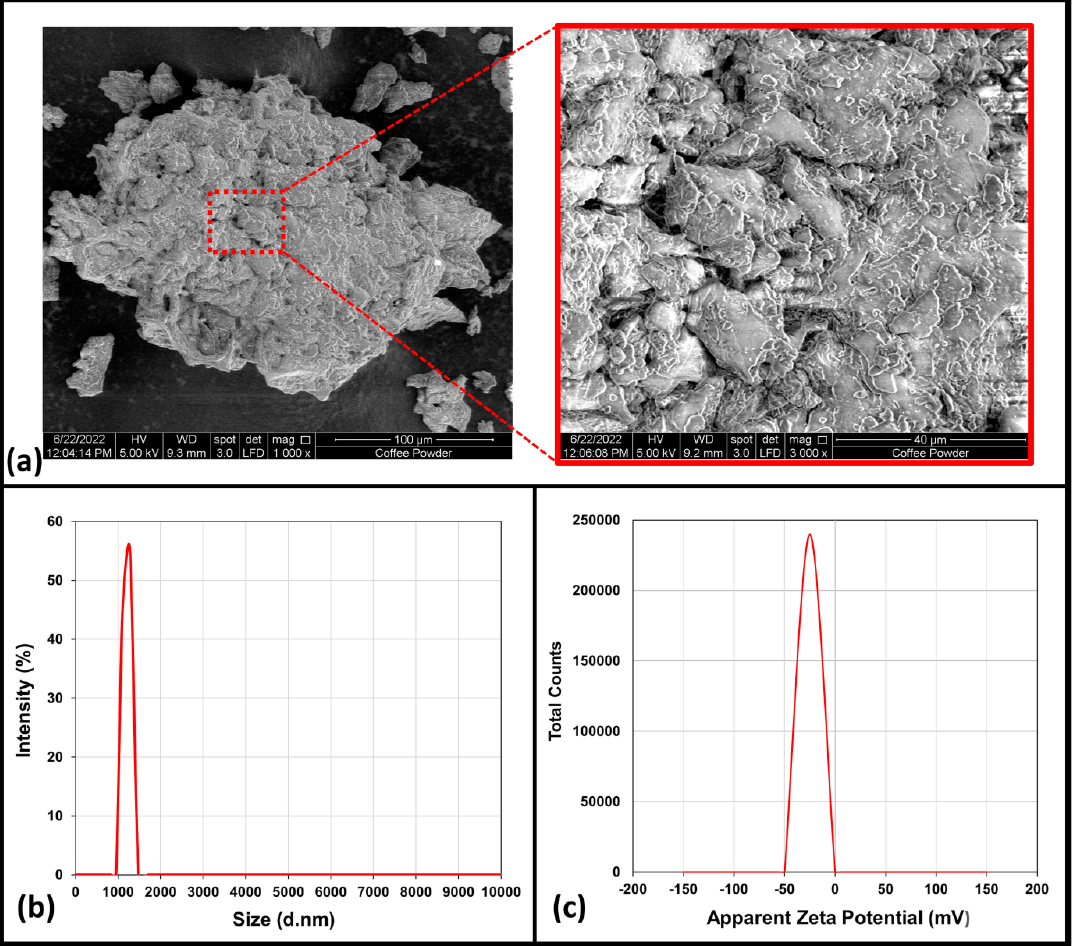
Figure 1. ( a ) SEM of coffee powder, ( b ) particle size distribution by intensity of coffee waste powder dispersion and ( c ) Zeta potential value of coffee waste suspension.